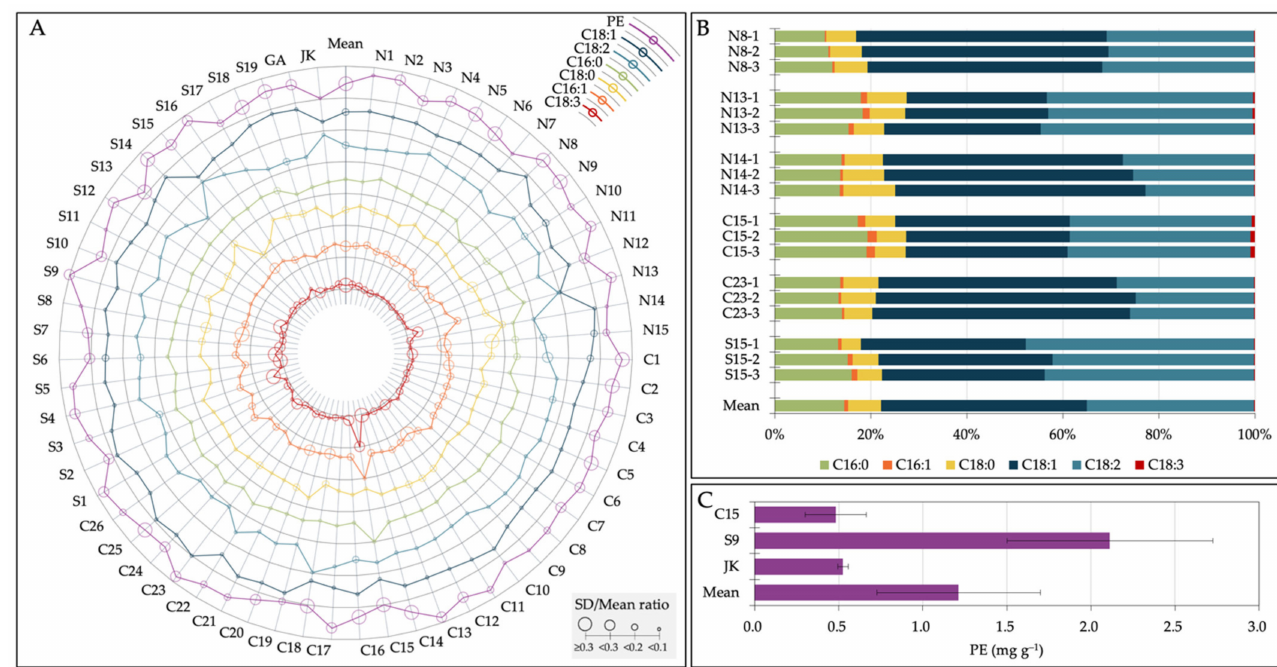
Figure 4. Variations of seed chemical traits in Botswanan Jatropha accessions. ( A ) A concentric circular plot showing the content of fatty acids and PE in each accession. The accession IDs are placed outside the radius, and the average content ( n = 3) is normalized and shown as a line plot in each track, where the inner and outer perimeters represent the minimum and maximum values, respectively, among all the accessions. Values for the fatty acid and PE components are shown in different colors, as depicted in the legend in the top right corner. The circles around the points illustrate the SD /mean ratios in each accession, which are categorized into four groups according to their relative magnitudes (>30%, 20–30%, 10–20%, and <10%), and expressed as differently sized circles, as depicted in the legend in the bottom right corner. ( B ) The fatty acid compositions (wt%) of representative Jatropha accessions. The profiles of three independent seeds for accessions N8, N13, N14, C15, C23, S15, and the mean of all accessions are shown. The color legend for each fatty acid is shown at the bottom of the panel. ( C ) PE content of representative accessions. The accessions with the lowest (C15) and highest (S9) PE content are shown, with accession JK and the mean of all accessions for comparison. The values are the mean ± SD ( n =